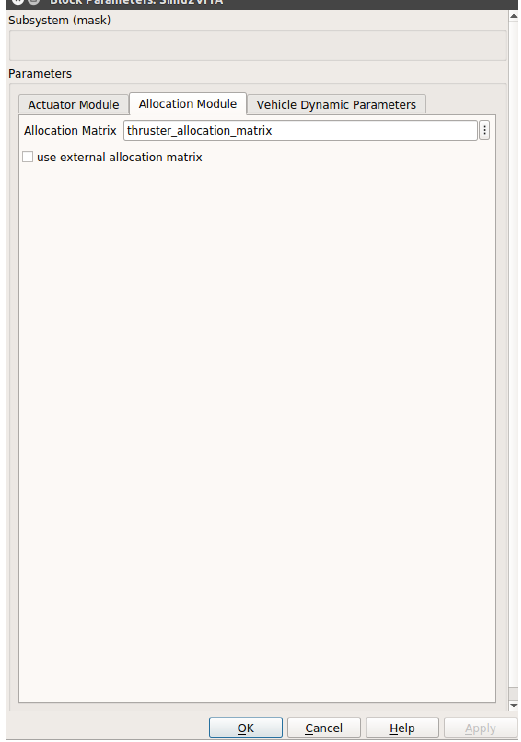
Figure A3. Simu2VITA interface for entering with simulation parameters for the Allocation Module.